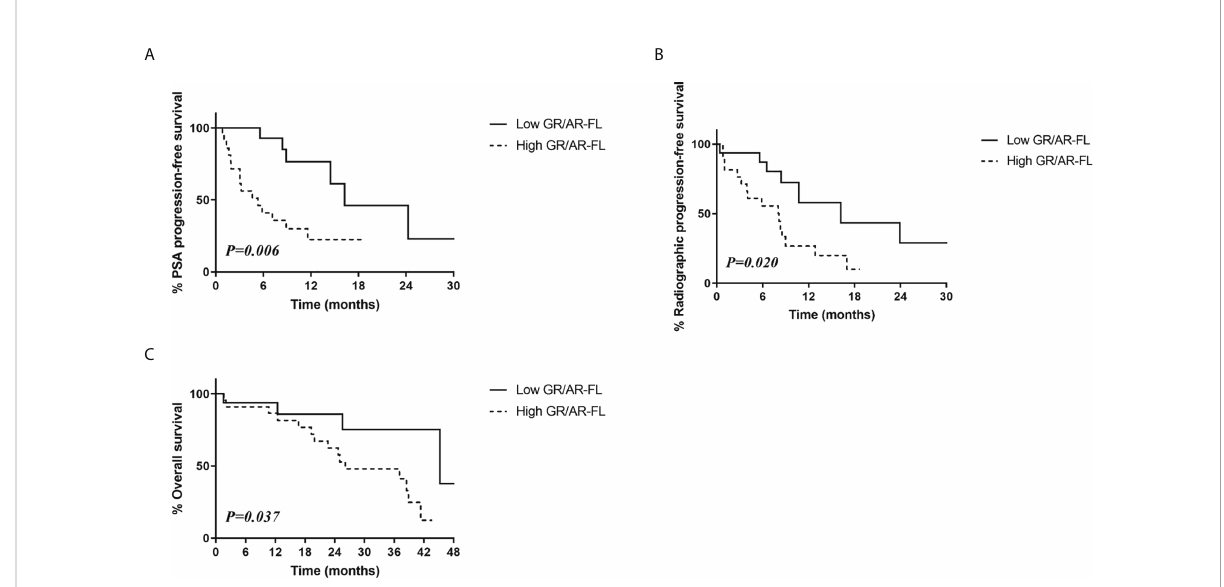
FIGURE 3 Relationship between survival outcomes and GR/AR-FL ratios in CRPC patients treated with AR-targeting therapy. (A) PSA progression-free survival. (B) Radiologic progression-free survival. (C) Overall